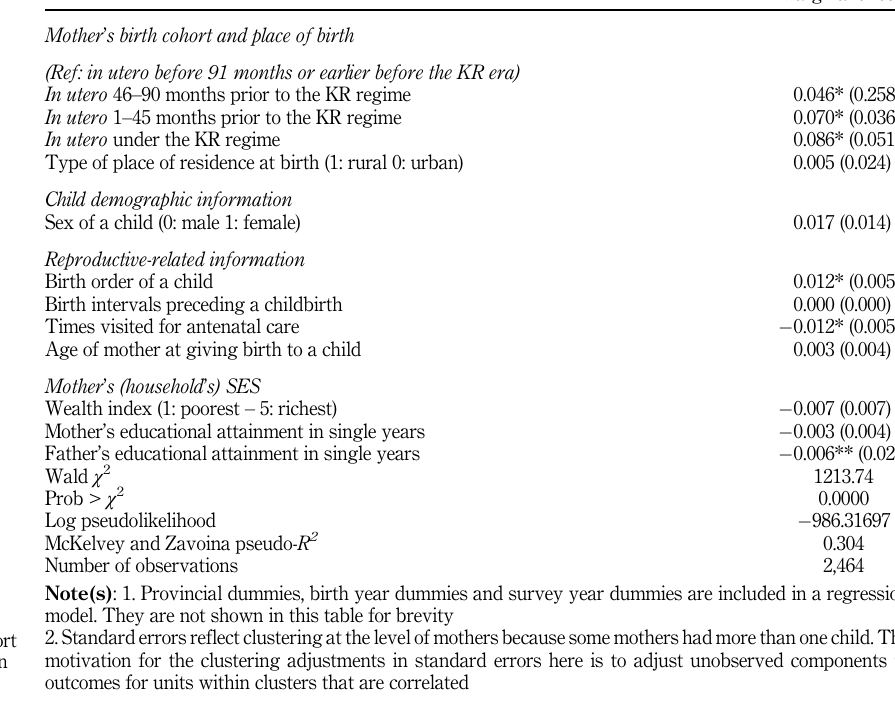
Table 3. Mother ’ s birth cohort and size of newborn